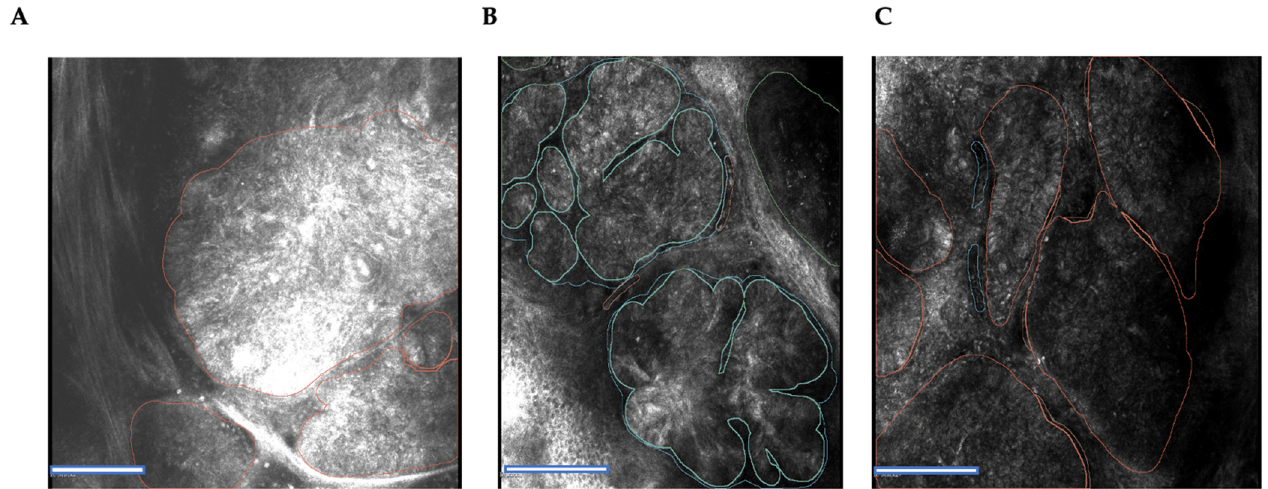
Figure 2. In vivo RCM images of BCC using the example of the criteria of bright tumor islands’ cores (the BTI core in green ( B ) is an example of the criterion, BTI core amorph. The BTI core in red ( A , C ) is an example of the criterion, BTI core round). Scale bar, 100 μ m.